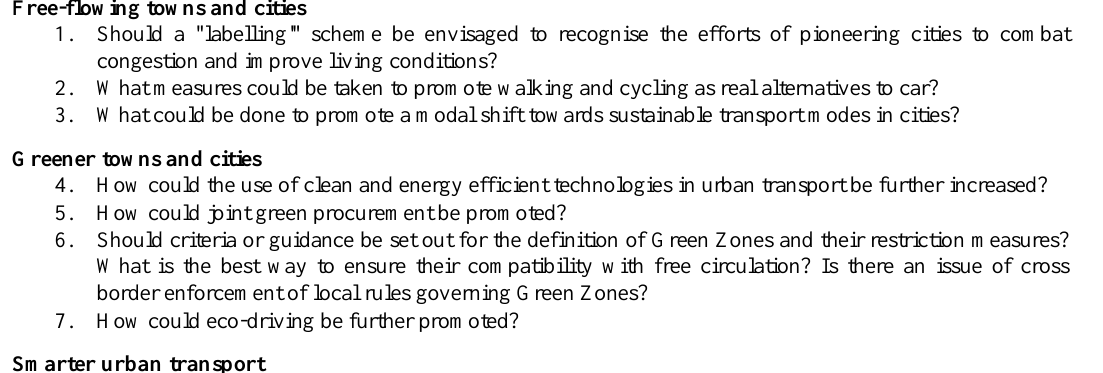
Table 1. Questions in the Green Paper on Urban Transport Free-flowing towns and